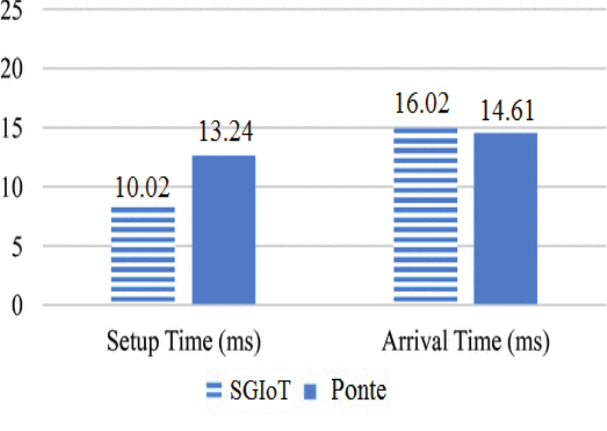
Fig. 7. MQTT – CoAP communication